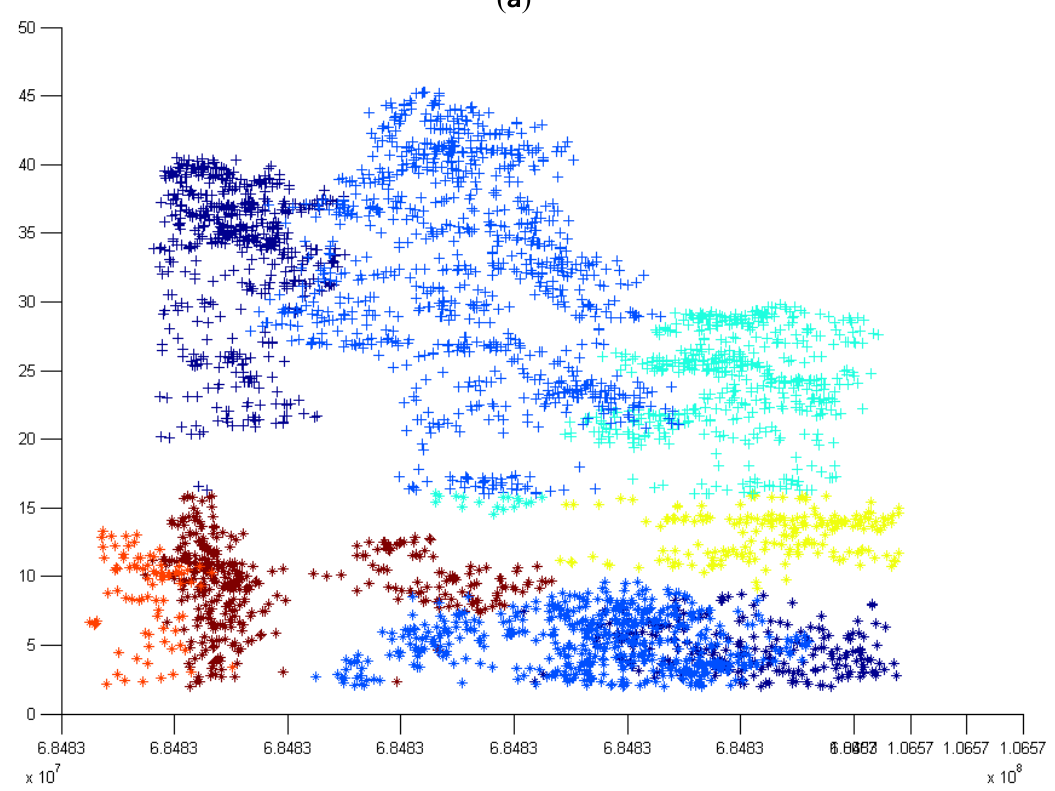
Figure 16. Result after running hierarchical tree clustering and scaling down the height value on two datasets of Cell 6 at different height levels. ( a ) Cell 6 clusters after hierarchical clustering in 2 height classes (between 2 and 16 m height and above 16 m height). ( b ) Cell 6 clusters after hierarchical clustering performed on dataset above 16 m height. The x and y coordinate values (in meters) are displayed horizontally and the z value (in meters) is displayed